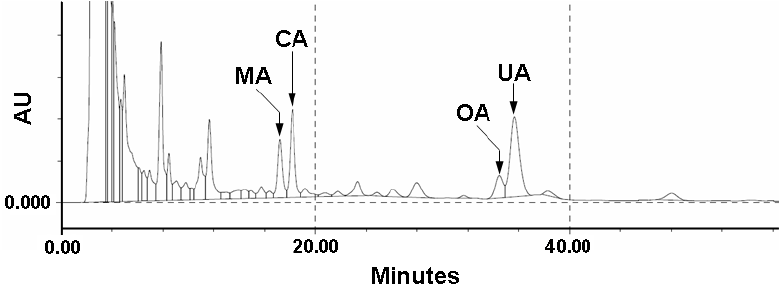
Figure 2. HPLC profile of four triterpenes derived from a CHCl E. japonica